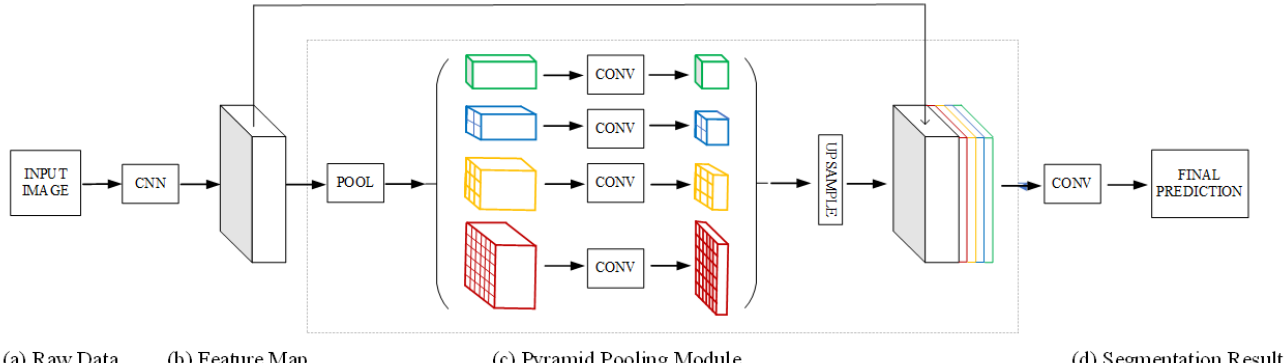
Figure 6. PSPNet Figure 6. PSPNet structure.